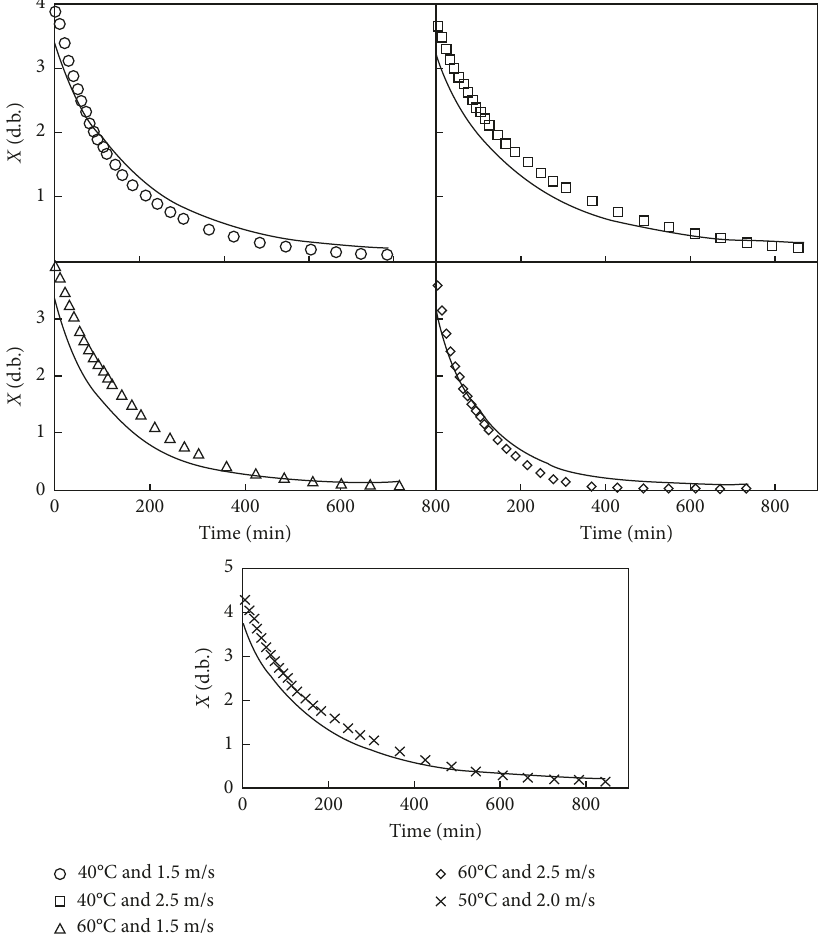
Figure 1: Drying kinetics of red araç´a fruits.